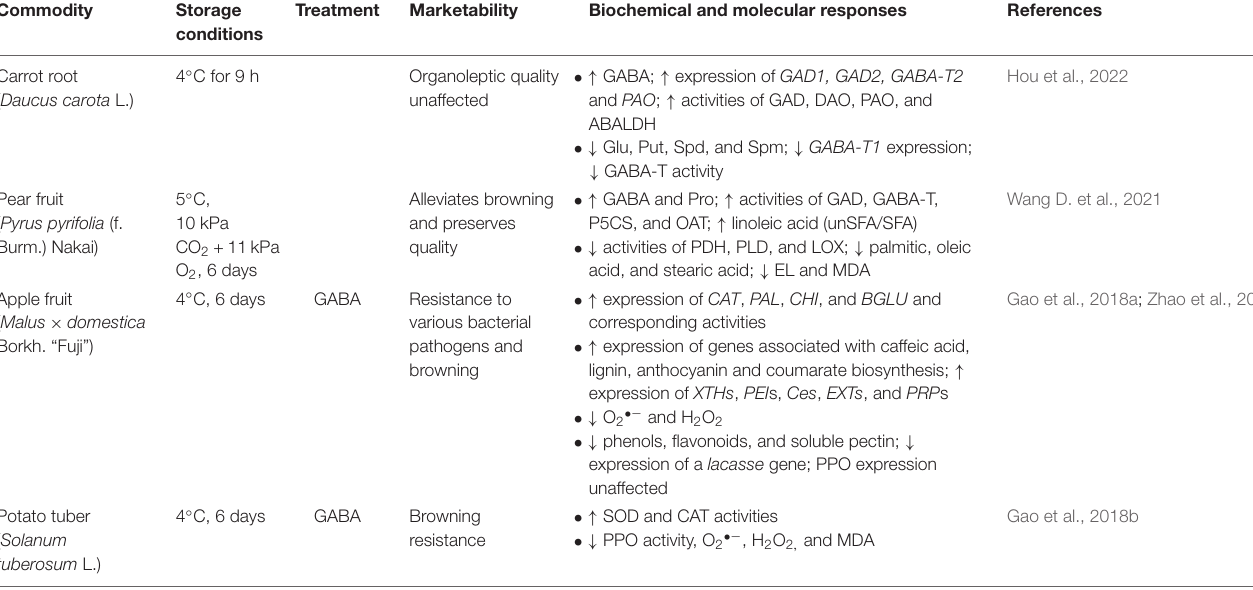
TABLE 4 | The postharvest marketability of fresh-cut horticultural commodities is improved by low temperature, controlled atmosphere conditions or exogenous